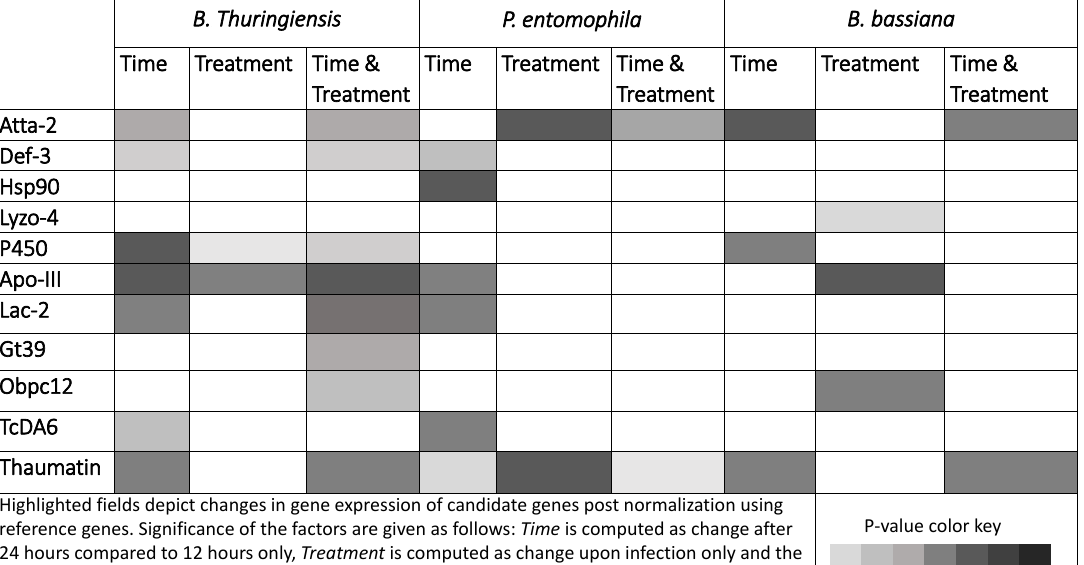
INFECTION (vs CONTROL).